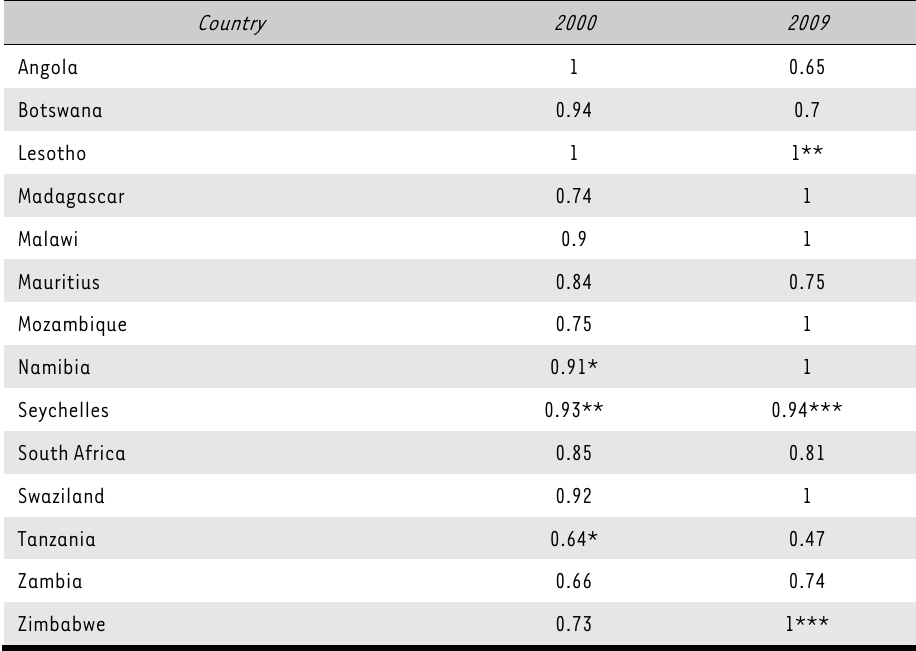
Bank concentration